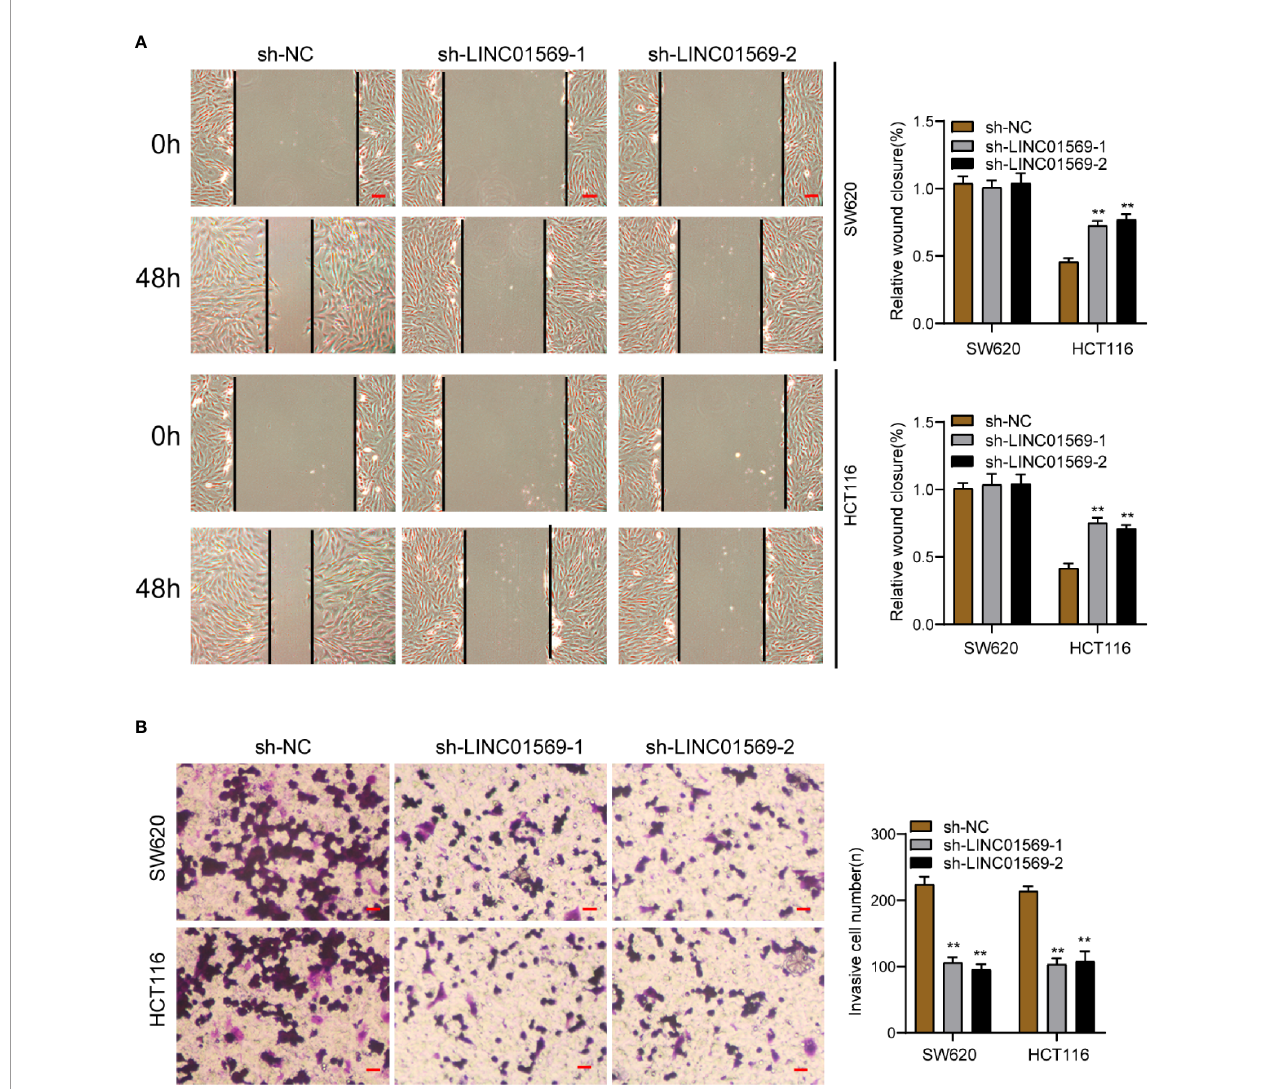
FIGURE 3 | LINC01569 promoted the migration and invasion of CRC cells. (A) Wound healing analysis of migratory rate in SW620 and HCT116 cells transfected with sh-NC or sh-LINC01569-1. (B) Transwell analysis of invasion in transfected SW620 and HCT116 cells. **P <